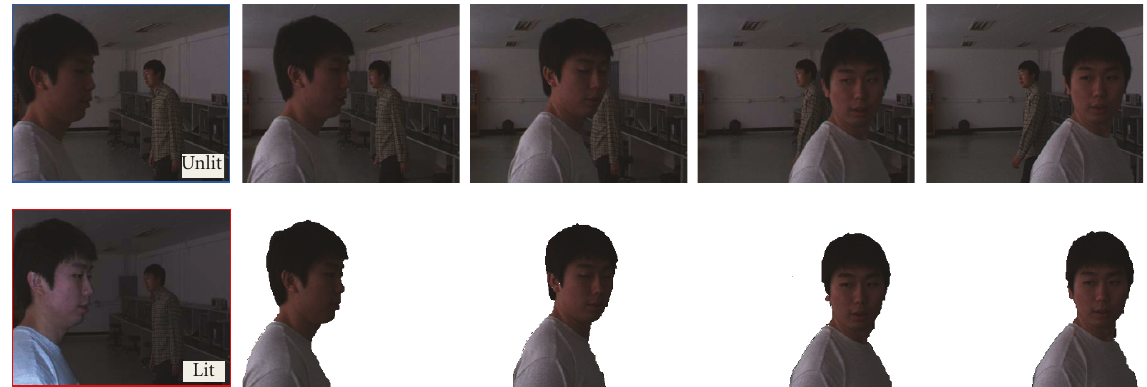
Figure 8: Segmentation of the “Moving Object and Background” sequence by the proposed algorithm I. The leftmost column shows a pair of unlit and lit frames, while the other columns show a series of unlit frames and their segmentation results.